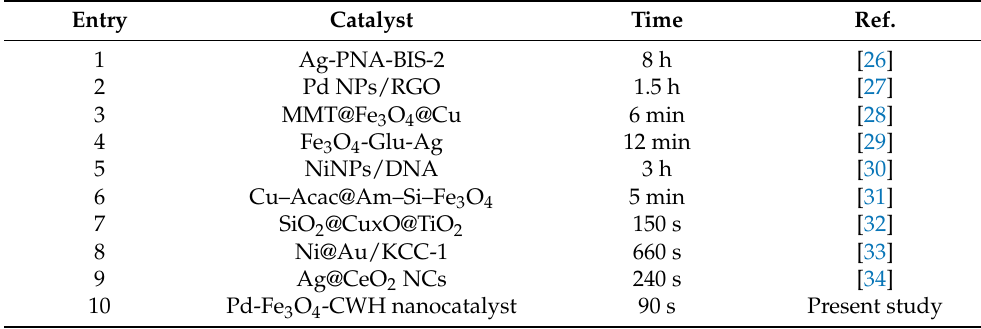
Table 3. Comparison of catalytic efficiency of Pd-Fe 3 O 4 -CWH with other reported catalysts in the 2-NA reduction.